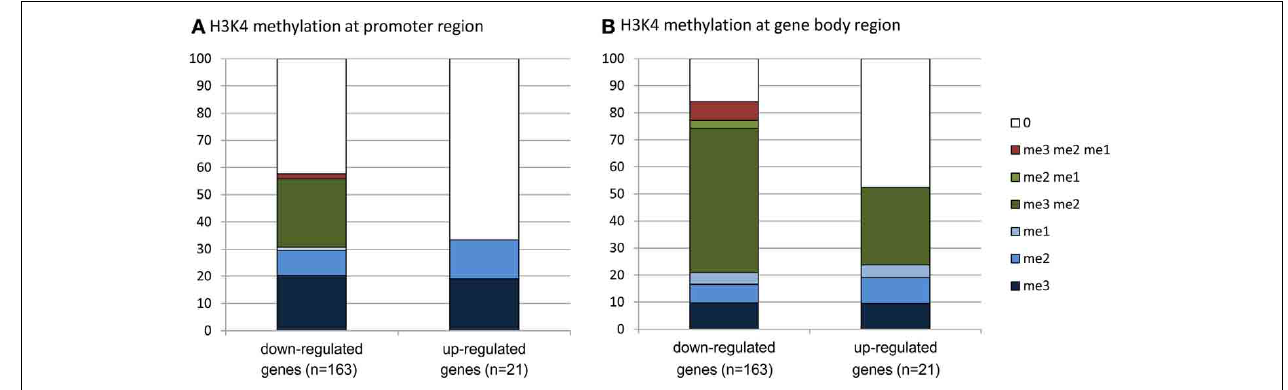
FIGURE 6 | Down-regulated genes are highly enriched for H3K4me2/3. Up-regulated (21) and down-regulated (163) genes in jmj15-1 or jmj15-2 mutants (changes > 2 folds) were compared with genome-wide H3K4